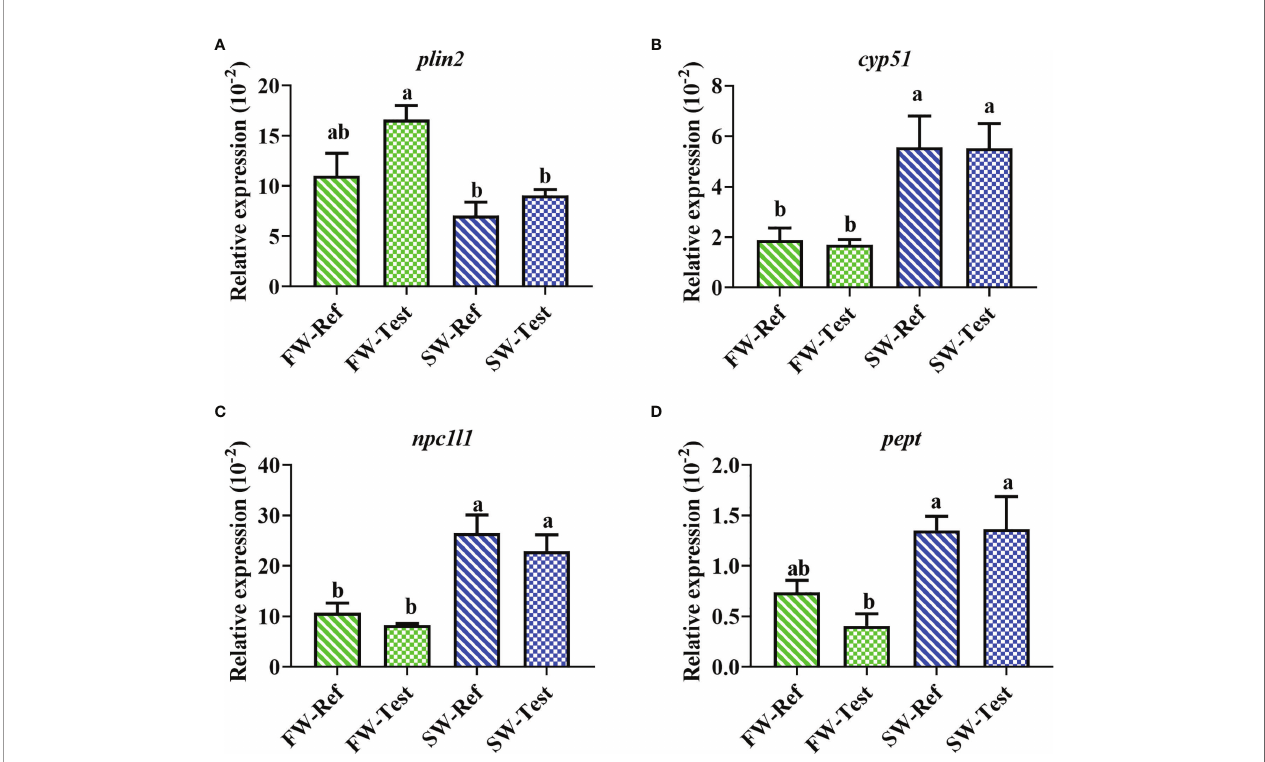
FIGURE 6 | Expression of genes in the pyloric caeca of Atlantic salmon among treatments. (A) surface marker of intestinal lipid droplets; (B) cholesterol biosynthesis; (C) cholesterol transport; (D) peptide transporter. Data are presented as mean ± SEM. Different letters among values denote signi fi cant differences ( p < .05) and values sharing the same letters are not signi fi cantly